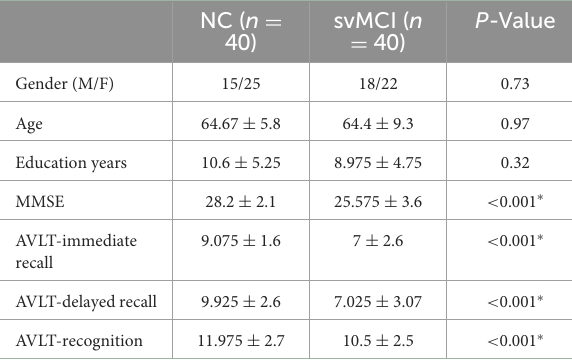
TABLE 1 Demographic characteristics of the